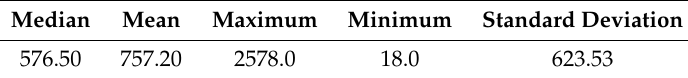
Figure 4. Mean hourly Wind power time-series. Table 1. Statistical details of wind power